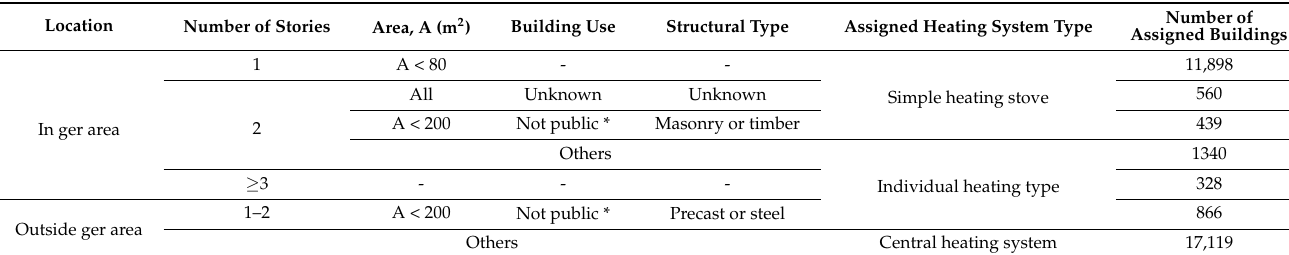
Table 4. Table of defining the heating type of